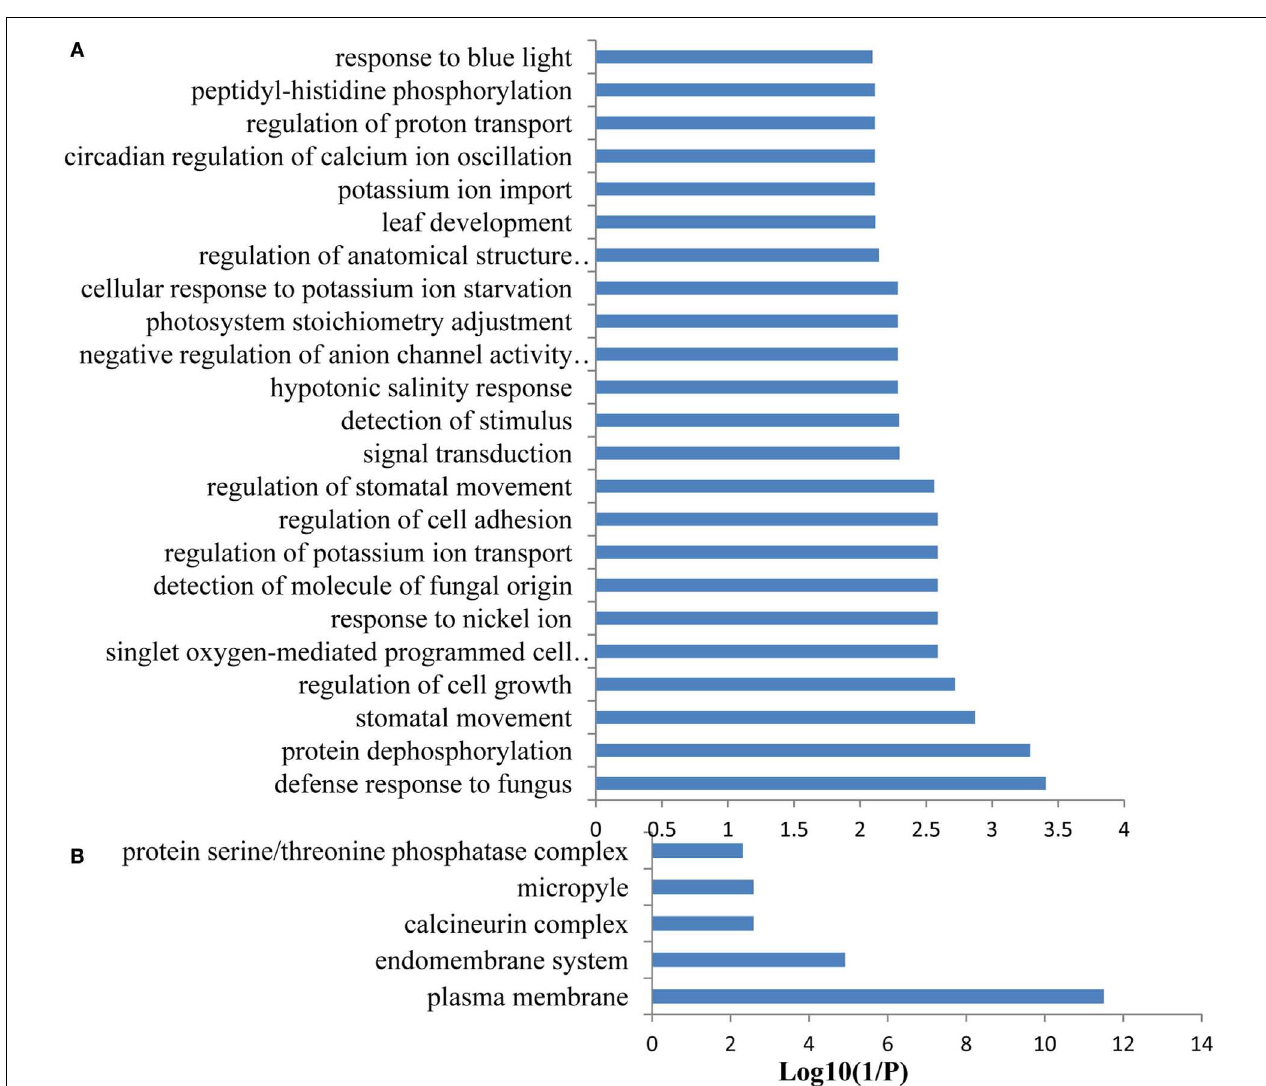
Ontology Browsing Utility (GOBU) (Lin et al., 2006) using theTopGo “elim” method (Alexa et al., 2006) with P < 0.01. (A) GO of the biological process and (B) GO of the subcellular